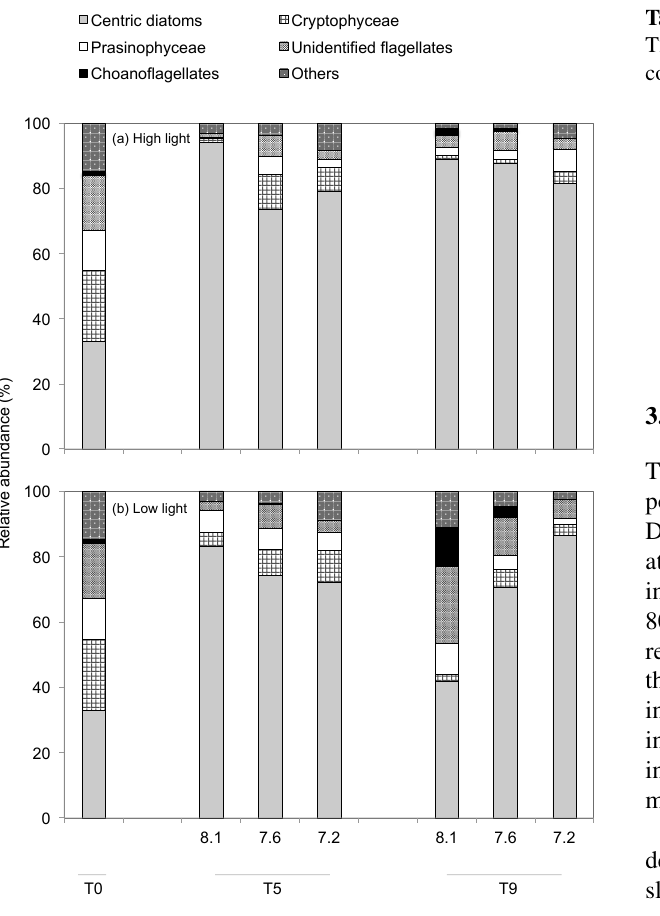
Figure 6. Relative abundance of six groups of protists at the begin- ning (T0), the middle (T5) and the end (T9) of the microcosm exper- iment for (a) high light (HL) and (b) low light (LL) treatments. The group “Others” includes pennate diatoms, Dinophyceae, Chryso- phyceae, Dictyophyceae, Euglenophyceae, ciliates and unidentified cells. Each bar plot represents a pH treatment. The bar plot at T0 represents the initial community assemblage before pH manipula- tions, and is therefore the same for both light treatments.